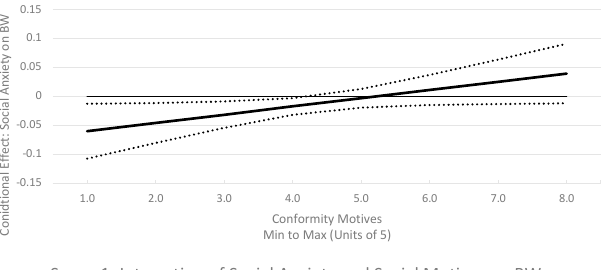
Scene 1: Interaction of Social Anxiety and Social Motives on BW